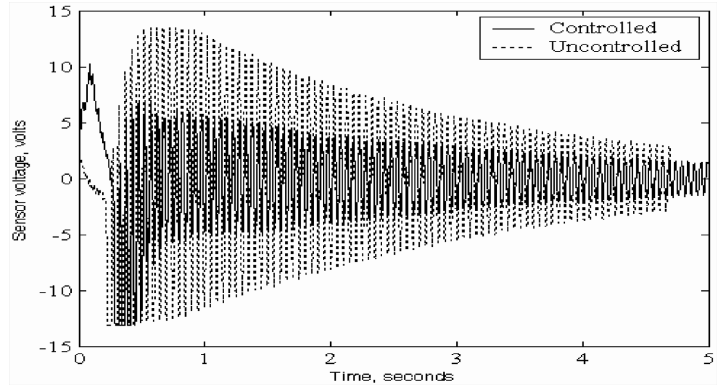
Fig. 12. SMC of plate with boundary layer.